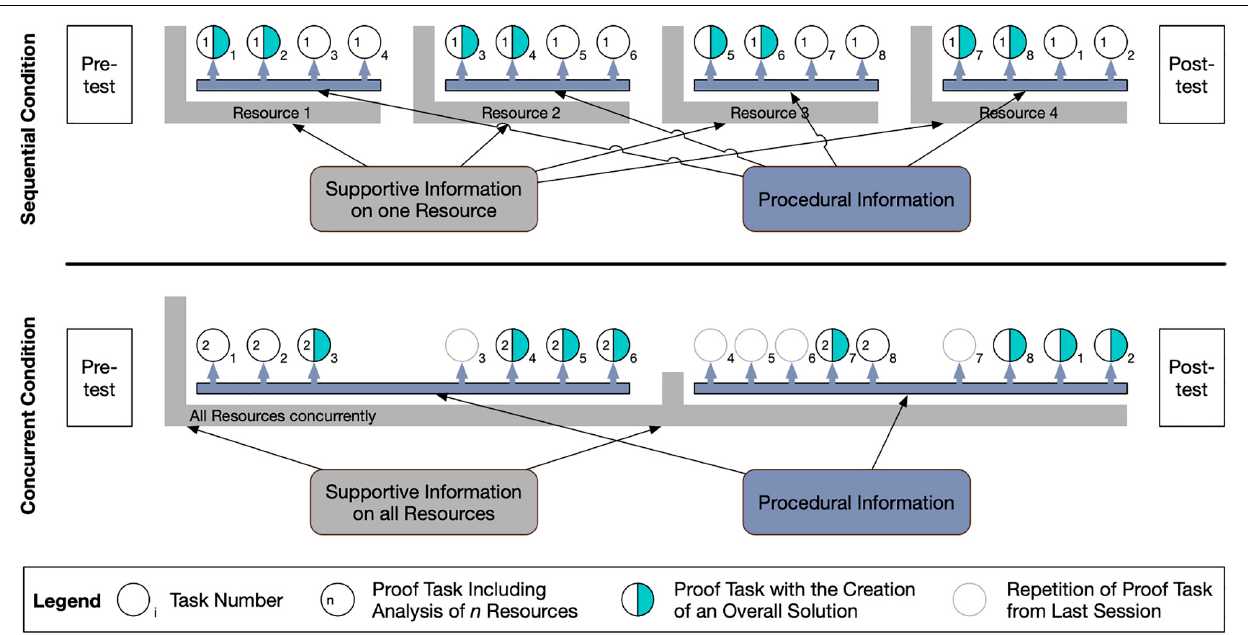
FIGURE 3 | Instructional design used for both conditions within the